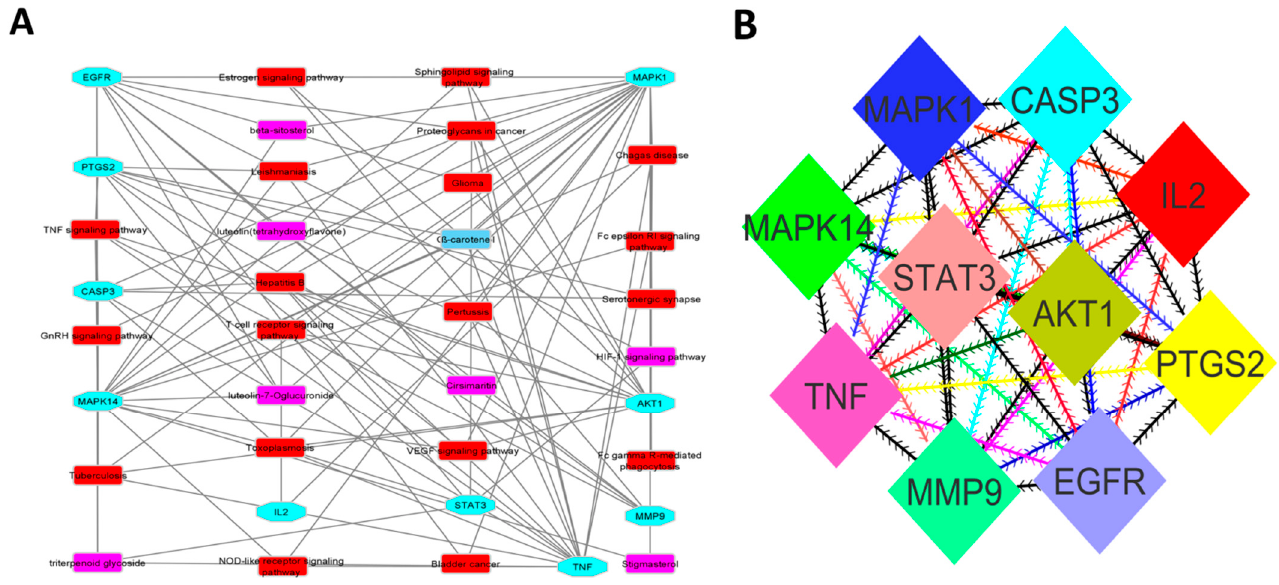
Figure 6. ( A ) Pathways predisposed by O. sanctum . Blue nodes show the hub genes, red nodes show the pathways, and pink nodes show the Compounds; ( B ) Cluster showing 10 key targets (Hub genes) analyzed by Cytoscape.